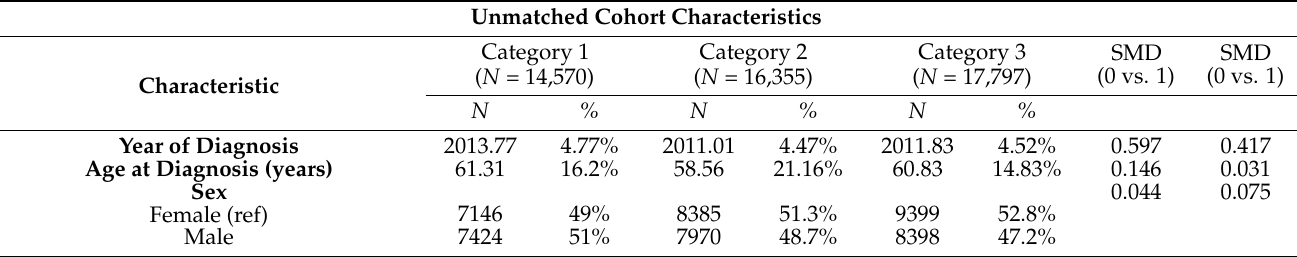
Figure 1. Cohort flowchart and provider patient racial diversity index . ( A ) Flowchart of neurosurgi- cal patients with central nervous system (CNS) malignancies included for analysis, derived from Op- tum 2003–2021. ( B ) Designation and breakdown of provider patient racial diversity index categories. Table 1. Unmatched and matched cohort